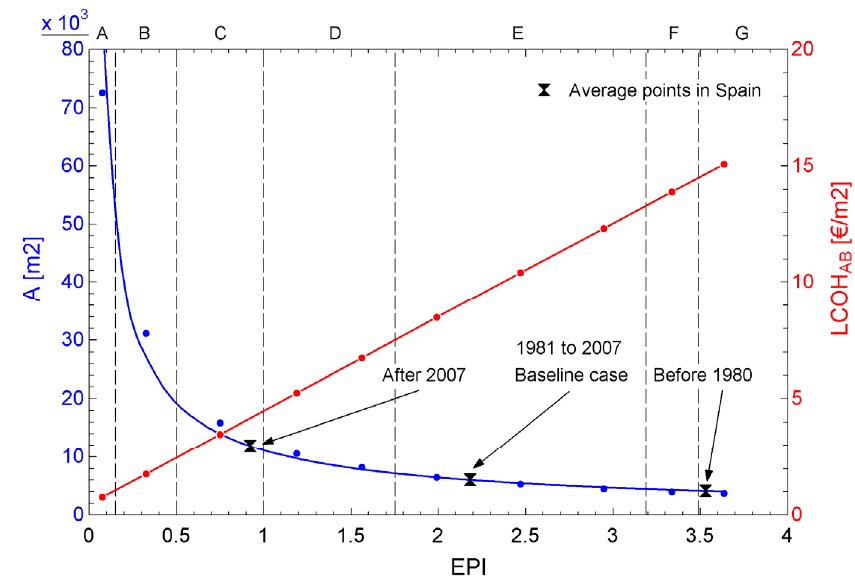
Figure 13. Required heated area (A) for each energy performance index (EPI) to maintain the same LCOH DB than in the baseline case (92.22 € / MWh) and LCOH AB obtained. Energy performance classes (A to G) limits are indicated in dashed lines.